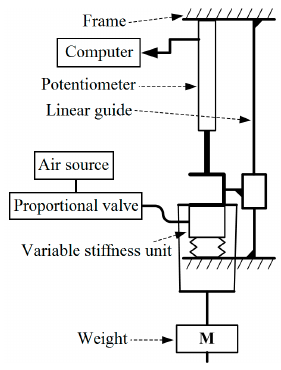
Figure 9. Schematic diagram of the experimental apparatus.